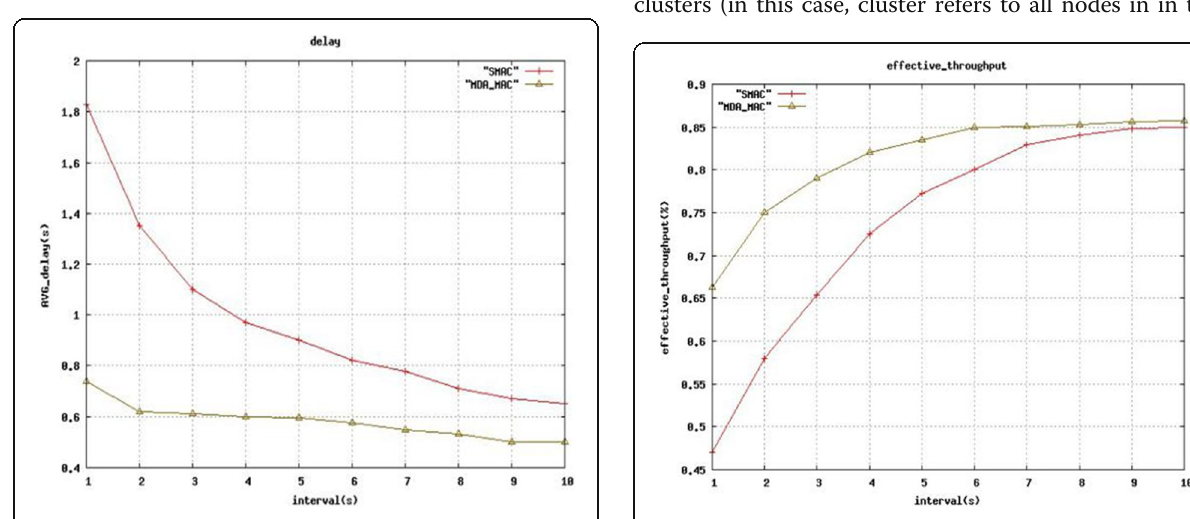
Fig. 6 The comparison of average delay Fig. 7 The comparison of effective